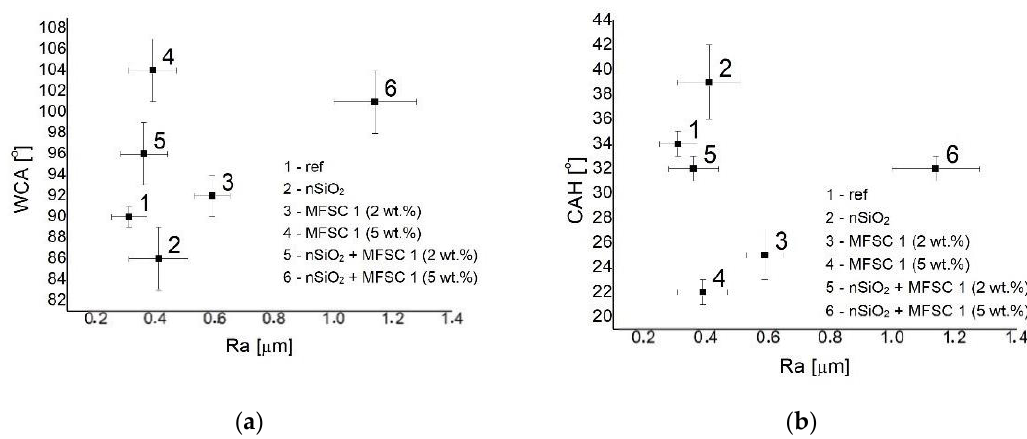
Figure 4. Relationship of ( a ) the Water contact angle (WCA) and ( b ) contact angle hysteresis (CAH) in the function of R a for samples modified with MFSC 1.